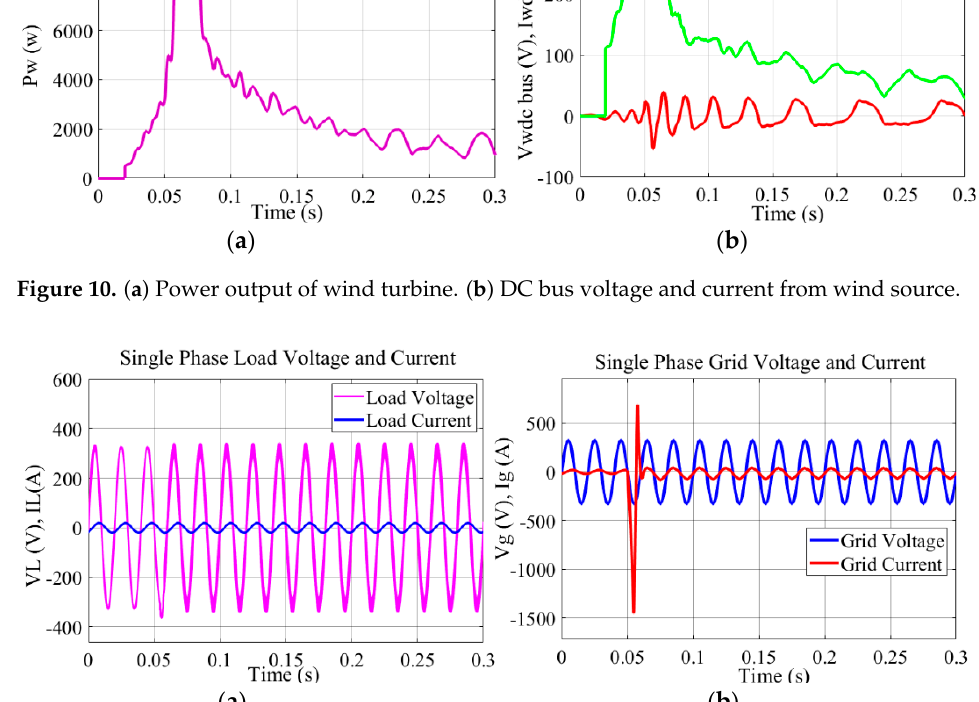
Figure 11. ( a ) Phase voltage and current of grid. ( b ) Load voltage and current.